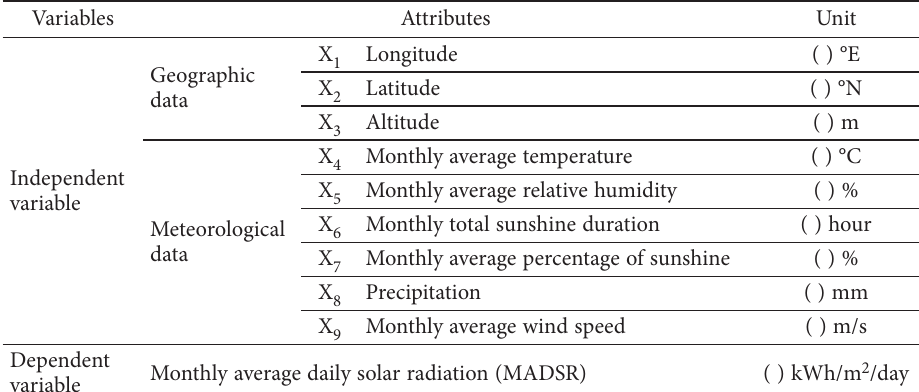
Table 1. Dependent variable and independent variables affecting the MADSR